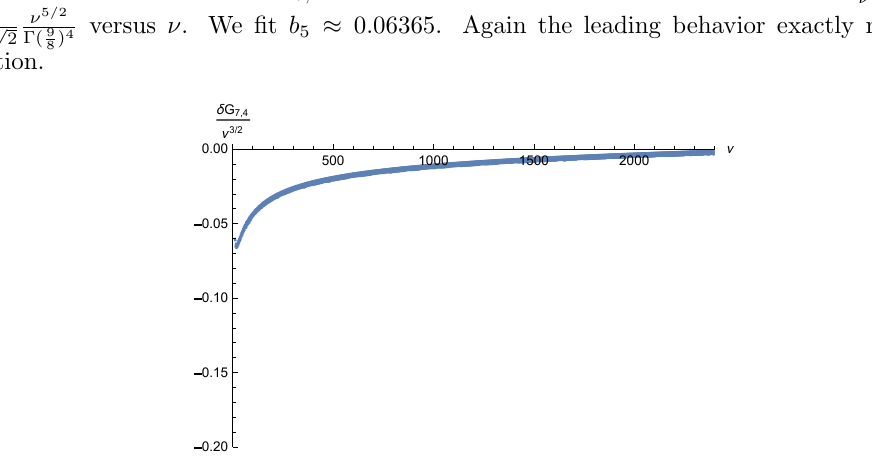
G J =2 ( (cid:23) ) (cid:0) 7 ; 4 (cid:23) 2